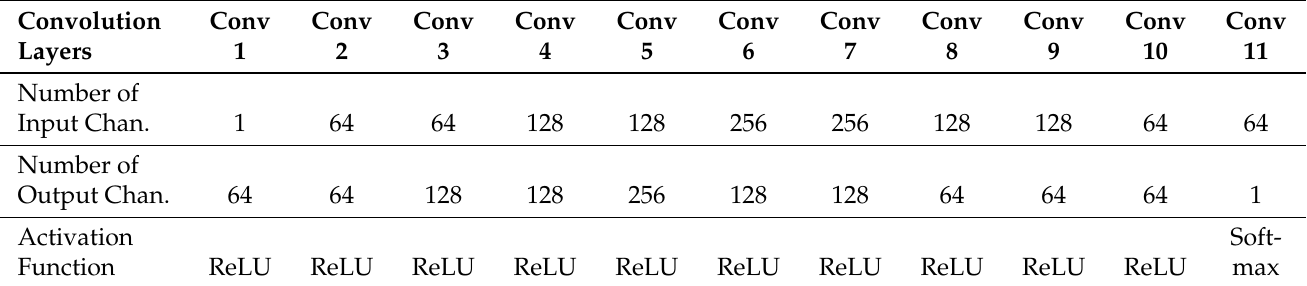
Table 3. Details of the convolution layers of the